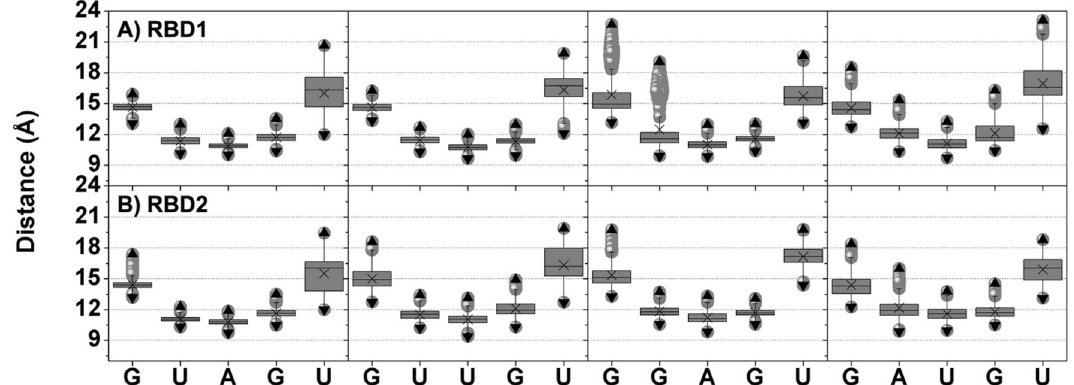
Figure 3. Distances between the centers of mass of each nucleotide and protein in ( A ) MSI1–RBD1 and ( B ) MSI1–RBD2, bound with the four RNAs. Data were taken from the last 20 ns of all five simulations (1000 snapshots in total). Grey boxes cover the area between the 25th and 75th percentiles, while whiskers determine the 5th, and 95th percentiles, respectively. Upward and downward triangles represent maximum and minimum values, respectively. Mean values are indicated by a cross, and outliers are depicted by